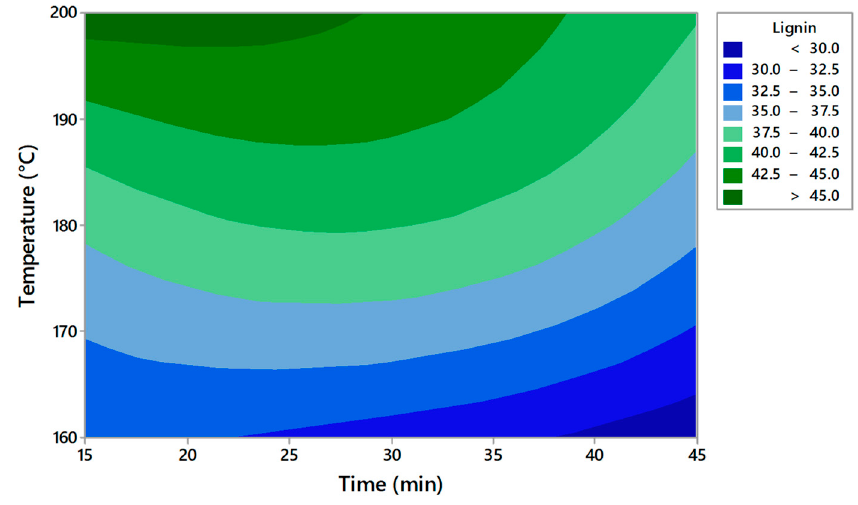
Figure 4. Contour plots of lignin content depending on time and temperature. Based on the contour plots, the theoretical results for solid yield, cellulose, hemicel- lulose, and lignin content versus temperature and time are presented in Tables 3–6. The p -value was used to observe the significance of the model The degree of freedom is the number of independent variables. The temperature has a low p -value of < 0.05 in all ex- periments, indicating a very high significance. A second-order polynomial was used to measure the correlation between the response and the independent variables. Table 3. Analysis of variance for solid yield.